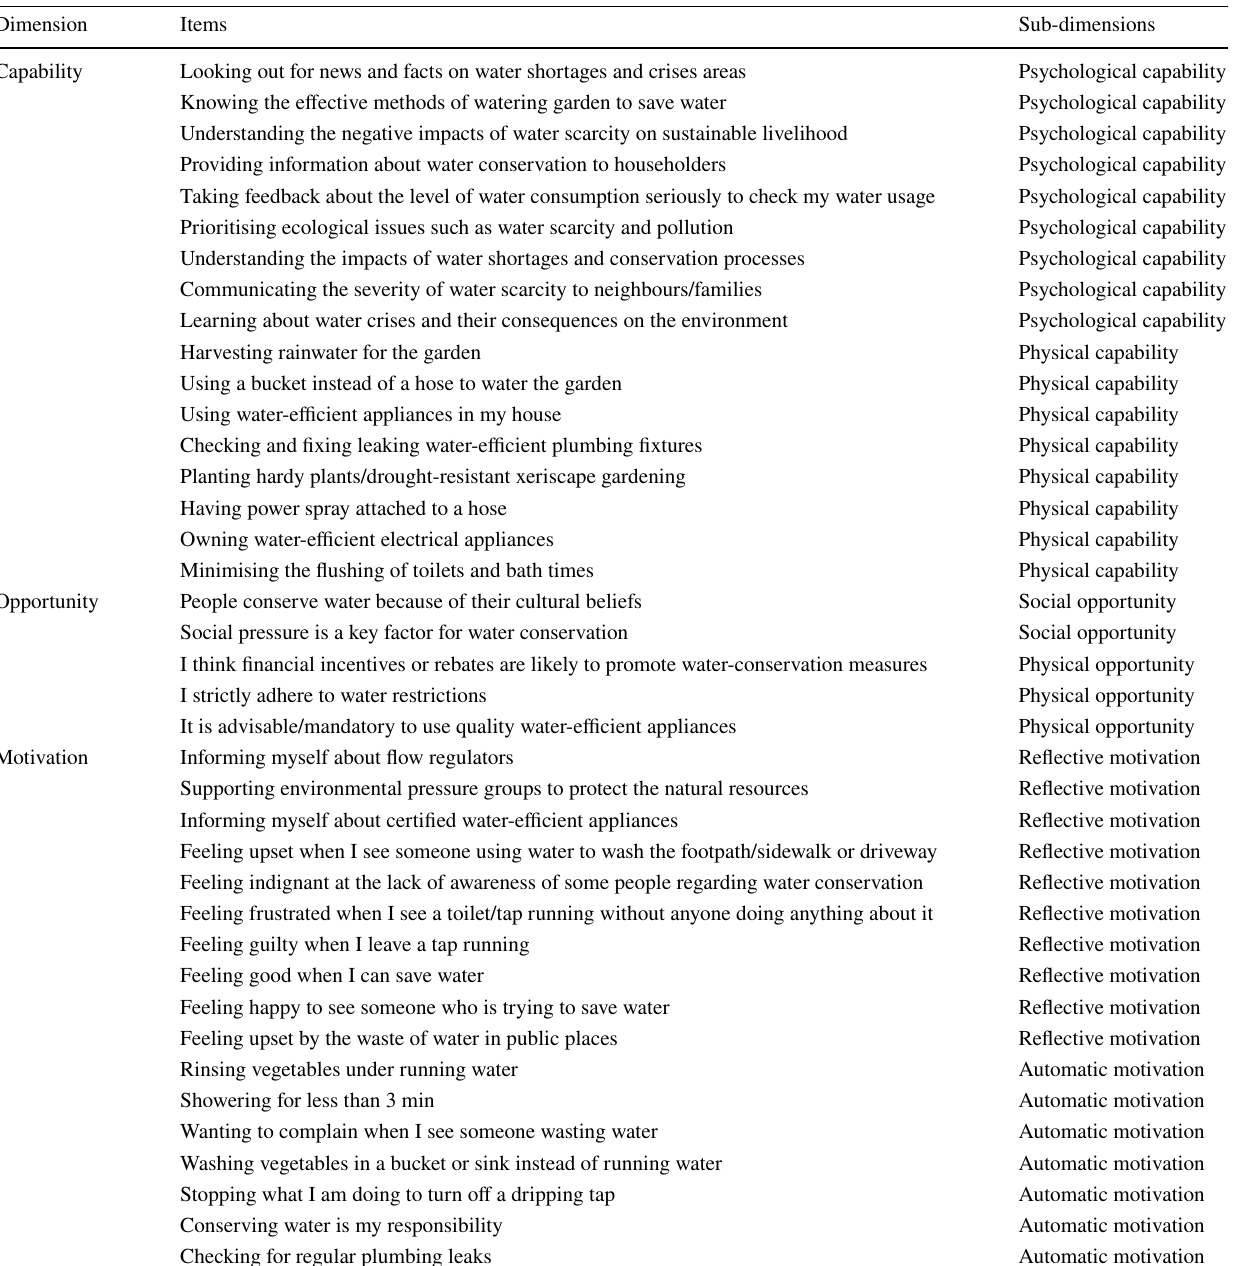
Table 4 Items comprising the COM-B scales